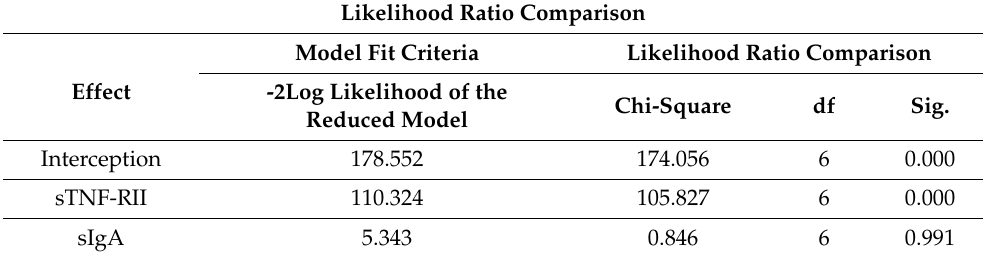
Table 6. Parameters for adjusting the multivariate logistic model between the original PAINAD